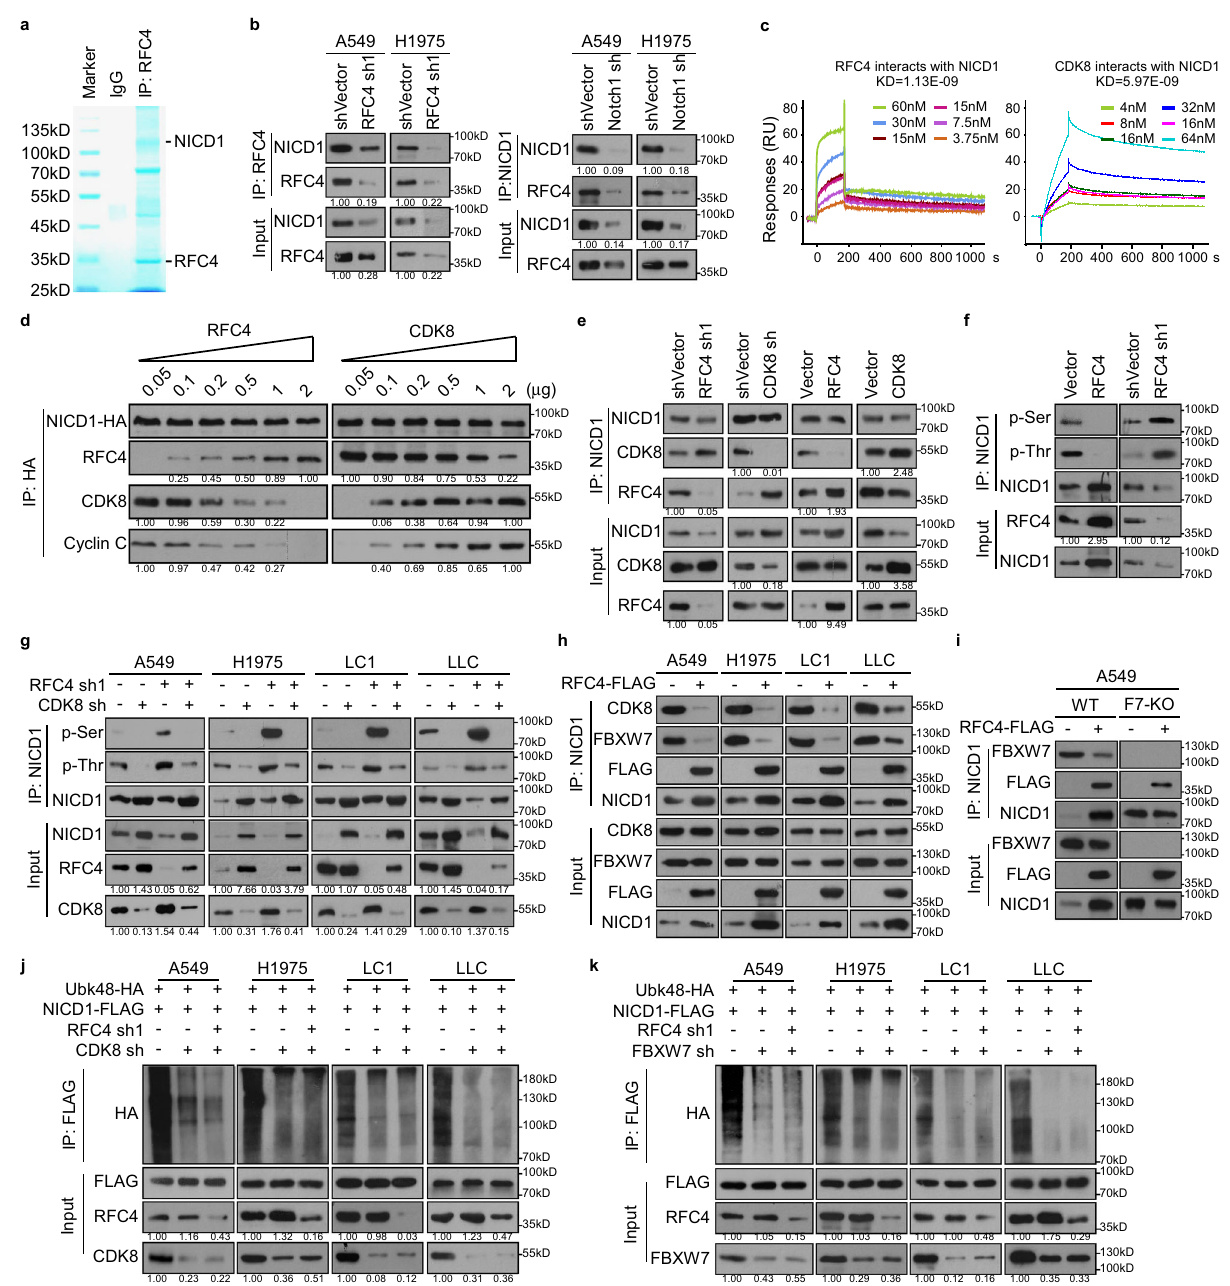
Fig. 5 RFC4 binds to stabilize NICD1 by abrogating CDK8/FBXW7-induced degradation. a MS peptide sequencing immunoprecipitated components, using anti-FLAG af fi nity puri fi cation, from lysates of A549 cells transfected with FLAG-tagged RFC4. b Immunoprecipitation assay revealing the interaction between RFC4 with NICD1. c SPR analysis measuring the af fi nity and kinetics of the interaction between RFC4 with NICD1 and CDK8 with NICD1. NICD1 was immobilized on a CM5 chip. d Lysates of 293FT cells transfected with NICD1-HA were immunoprecipitated by anti-HA af fi nity gel and incubated with puri fi ed RFC4 or CDK8 proteins, followed by addition of the indicated doses of puri fi ed CDK8, RFC4 proteins. The resultant incubates were analyzed by WB with the indicated antibodies. e The interaction between NICD1 and CDK8 or RFC4 in the presence or silencing of RFC4 or CDK8 was evaluated by immunoprecipitation of NICD1. f , g WB analysis of the effect of overexpressing or silencing RFC4 or together with CDK8 silencing on serine and threonine phosphorylation levels of immunoprecipitation pull-downed NICD1. h The interaction between NICD1 and CDK8 or FBXW7 in the presence or absence of RFC4-FLAG was evaluated by immunoprecipitation of Notch1. i The interaction between NICD1 and FBXW7 in the presence or absence of RFC4-FLAG was evaluated by immunoprecipitation of NICD1-HA in A549 WT and FBXW7 knockout cells. j , k The levels of K48-linked polyubiquitination of NICD1 were evaluated by immunoprecipitation of FLAG-tagged NICD1 in A549, H1975, LC1, and LLC cells with the indicated treatments. Source data are provided as a Source Data fi le, except Fig.